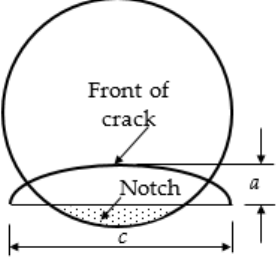
Figure 17. Schematic diagram of crack depth a and width c .